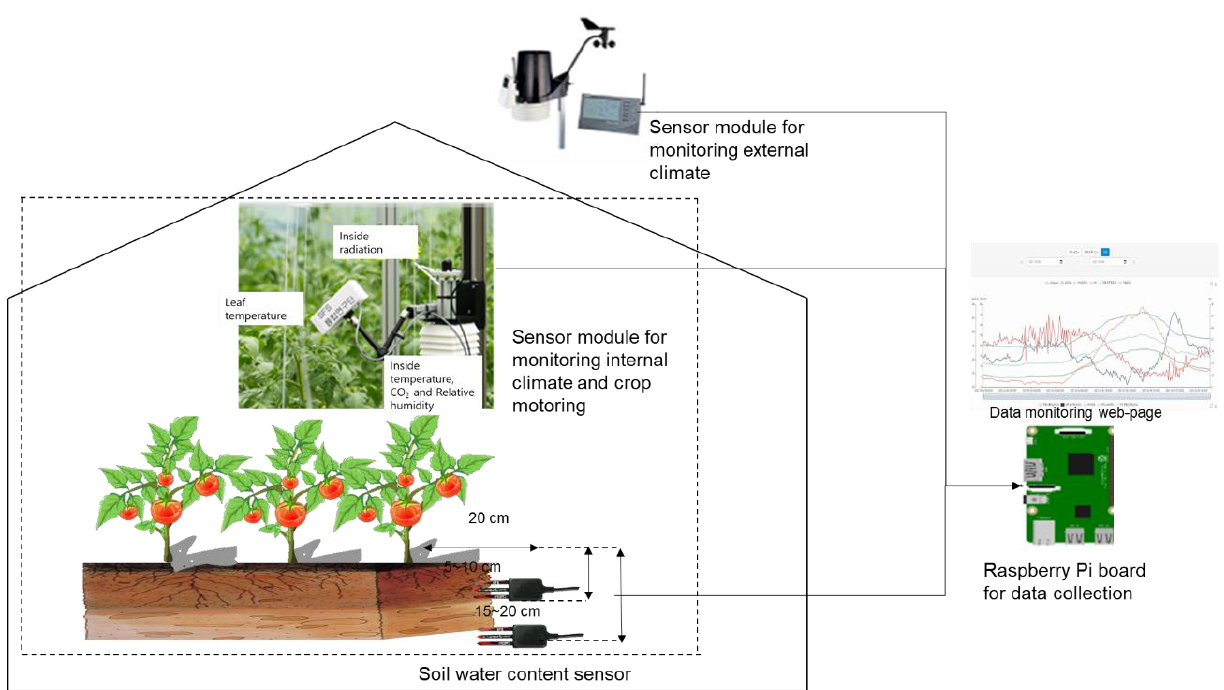
Figure 1. All monitoring sensors in the greenhouse used for data acquisition.